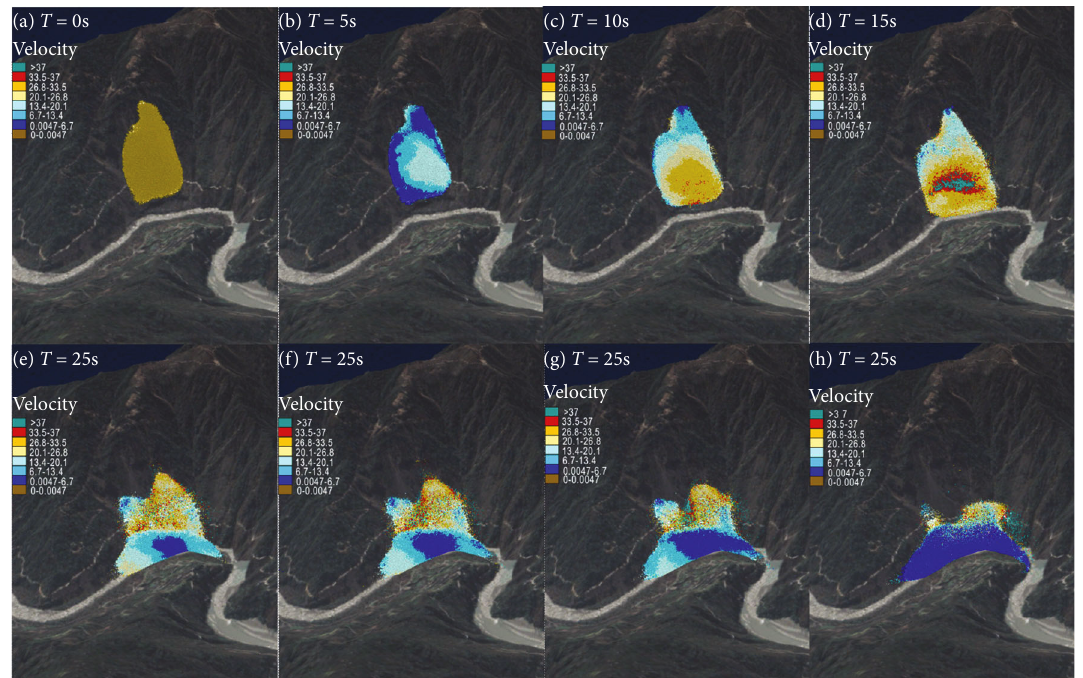
Figure 10: Simulation of the velocity movement of the Tangjiashan landslide.